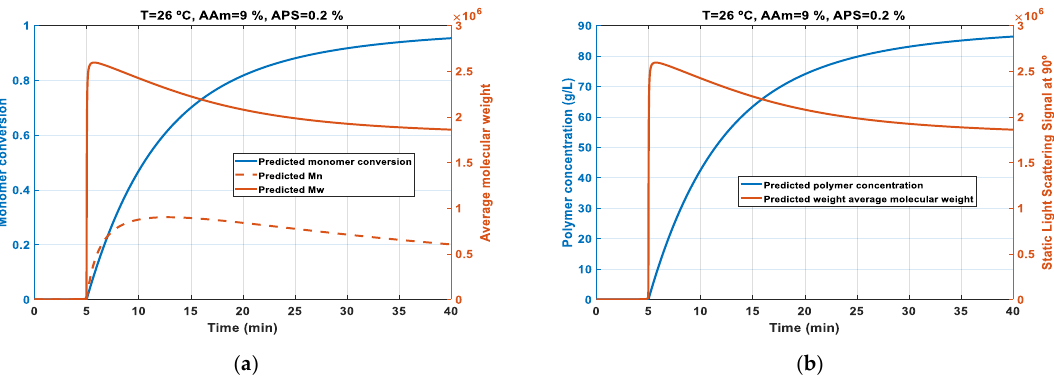
Figure 5. Predicted time-evolution of monomer conversion, polymer concentration, and average molecular weights for a typical run performed in this work concerning acrylamide polymerization with APS/TEMED initiation. ( a ) Monomer conversion, 𝑀̅ 𝑛 and 𝑀̅ 𝑤 . ( b ) Polymer concentration (g/L) and 𝑀̅ 𝑤 . The detailed experimental conditions correspond to product L2 in Table 1.